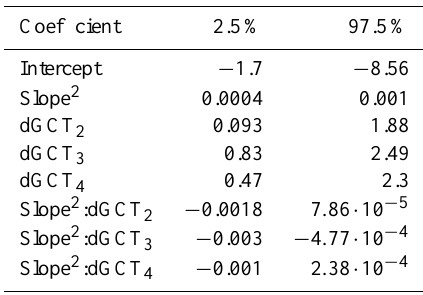
coefficients (Model